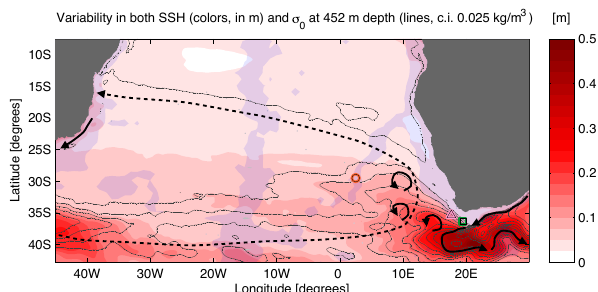
Fig. 1. Map of the southeast Atlantic, with location of the core stud- ied here (orange circle), of the Cape Basin record (pink triangle) of Peeters et al. (2004), and of the Agulhas Bank Splice (green square) of Martínez-Méndez et al. (2010). Also indicated are con- toured variabilities of both SSH (colours) and of σ θ at the 452m depth model level (lines) over the basin, in the INALT01 model (see Methods). The blue arrows show the schematics of the water cur- rents discussed here: Agulhas Current, Agulhas rings and cyclones, and South Atlantic Gyre